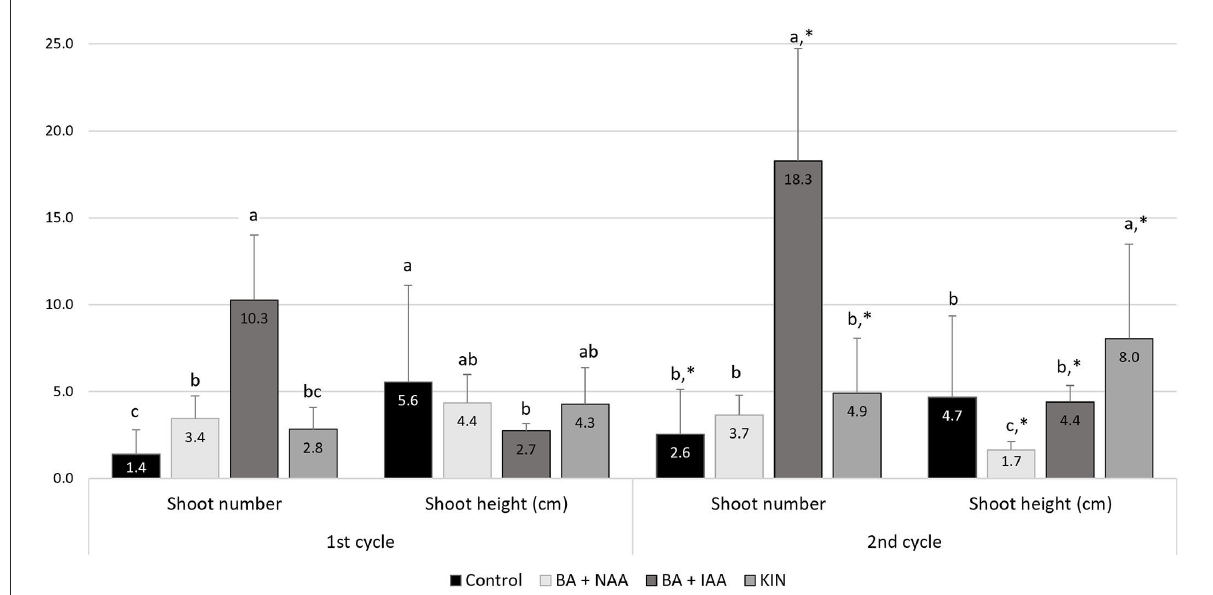
FIGURE1 Effect of two consecutive cycles of in vitro shoot multiplication of sea knotgrass explants cultivated in MS medium alone (control) and with different growth regulators (0.06 mg/L BA + 0.24 mg/L NAA, 3 mg/L BA + 0.1 mg/L IAA, and 2 mg/L KIN) after 60 days. Values correspond to mean ± SD of three independent experiments ( n = 30). For each group, columns marked with different letters (a–c) are considered statistically different at p < 0.05 (Tukey’s HSD), while columns marked with * are significantly different to the respective treatment of the first cycle ( p < 0.05; Tukey’s